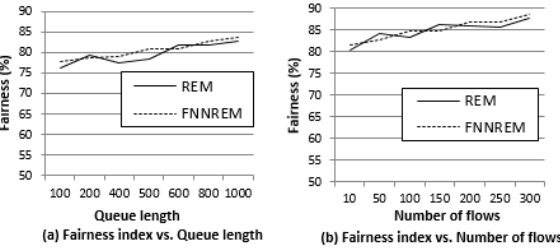
Figure 14. The fairness of active queue management mechanisms